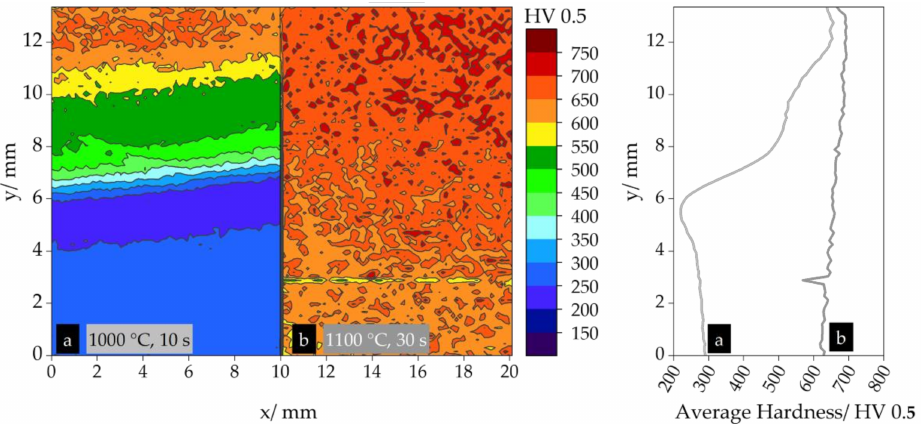
Figure 7. Two false-color images of a planar hardness profile 1000 ◦ C, 10 s ( a ) and 1100 ◦ C, 30 s ( b ).